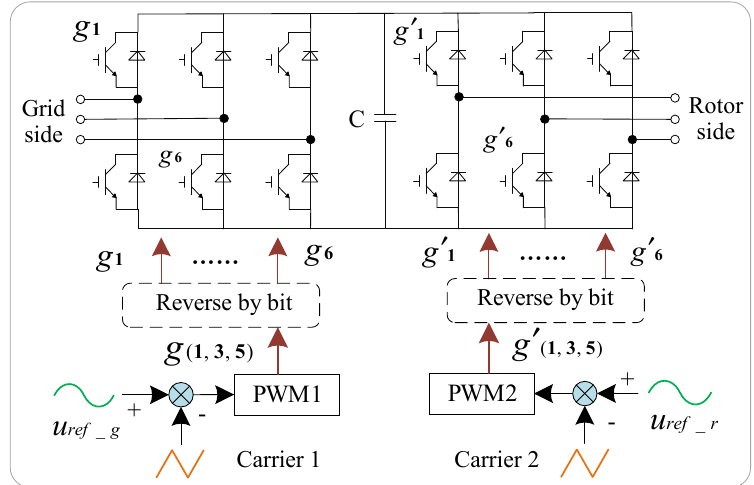
Figure 2. Detailed block diagram of the back-to-back converter.